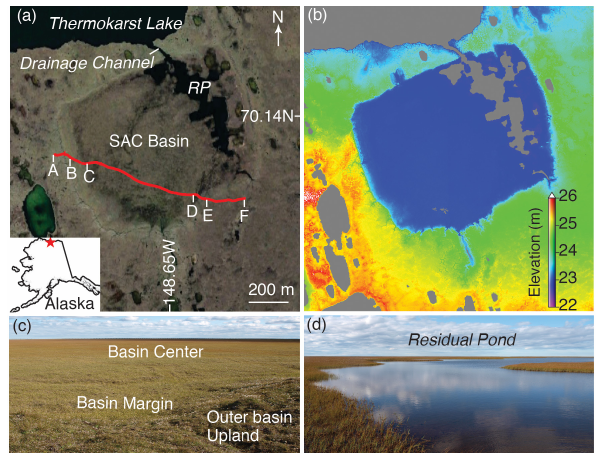
Fig. 1. (a) Google Earth © image of SAC basin with the inset show- ing its location on the Alaskan North Slope near Prudhoe Bay. The red line (“A” to “F”) shows the ground penetrating radar (GPR) tran- sect across the basin and “RP” refers to the residual pond. (b) Ele- vation map with standing water bodies masked out in gray (source: Paine et al., 2013). (c) A photo of the basin center taken from point “A” looking east. (d) A photo of the residual pond.